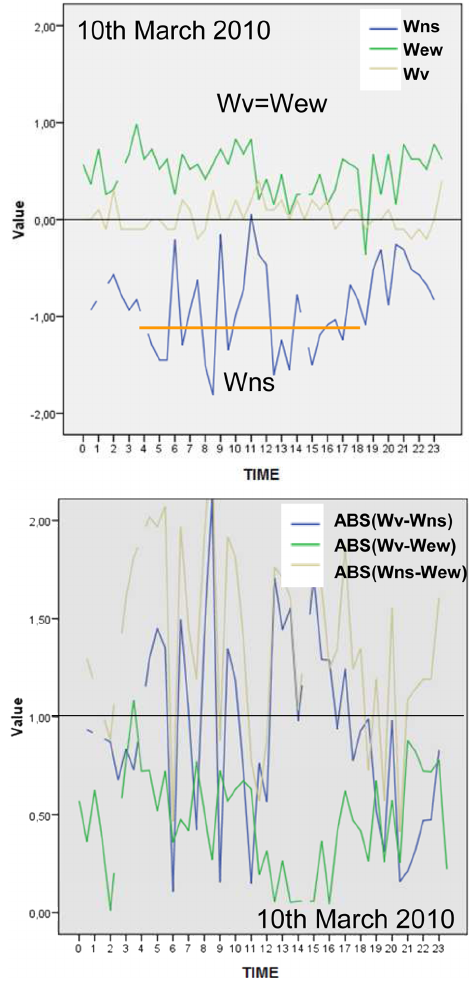
Fig. 7. North pattern: time-series plots on 10 March 2010. (top) Vertical velocities. x axis (time UTC). y axis (velocity in ms − 1 ) . The orange line indicates the negative deviation of W ns . (bottom) Absolute values of the differences between velocities. x axis (time UTC). y axis (velocity in ms − 1 )